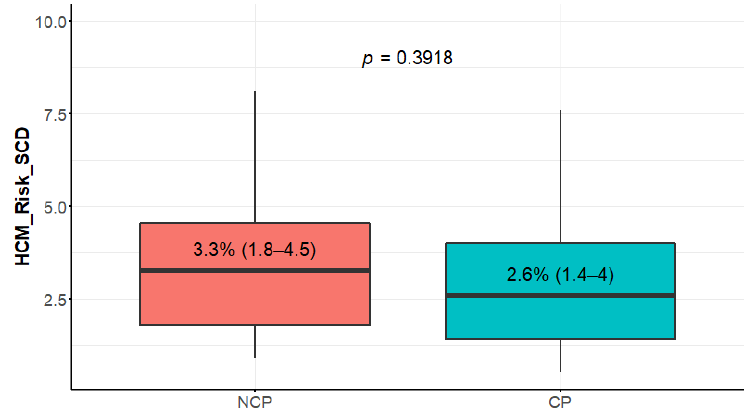
Figure 2. HCM risk score (hypertrophic cardiomyopathy European Society of Cardiology risk score) in NCP (nonclassic phenotype) and CP (classic phenotype) patients. Data presented in boxplot as median values, interquartile range, and minimal and maximal values.